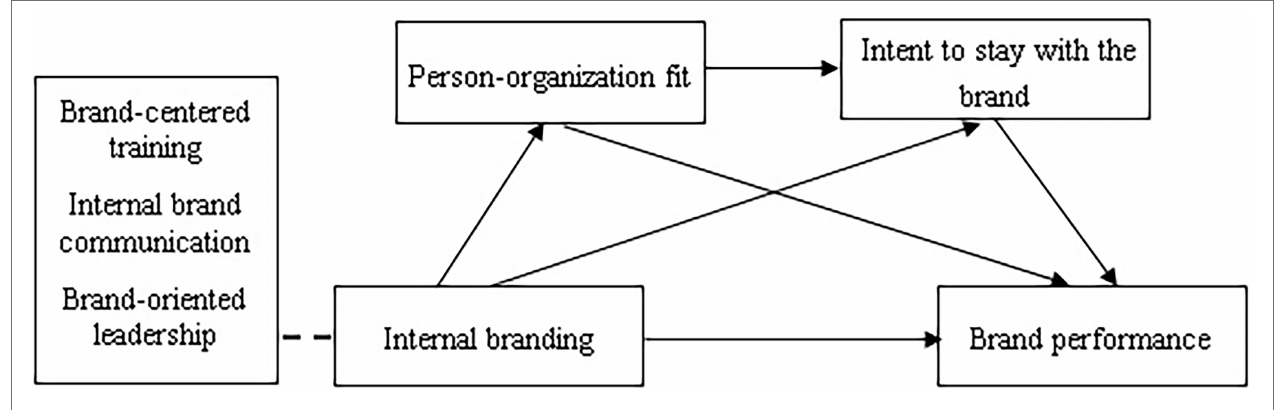
FIGURE 1 | The conceptual